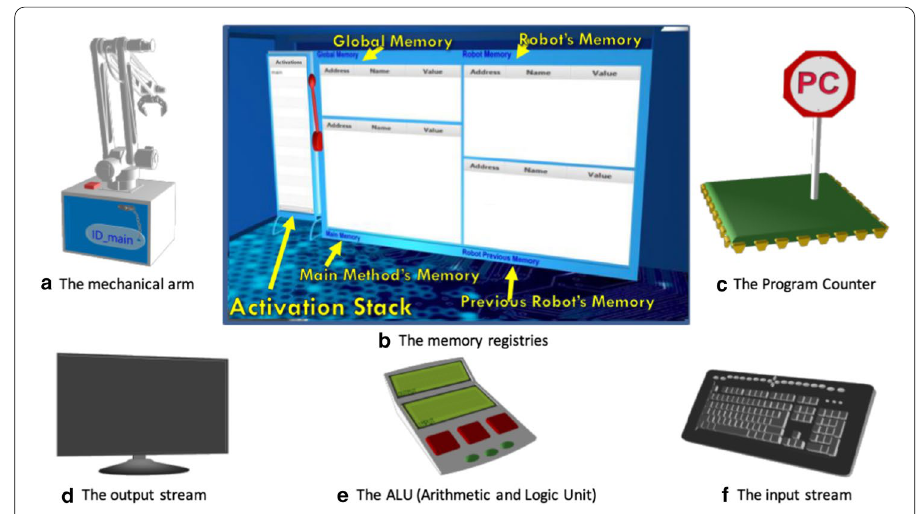
Fig. 2 Procedural programming. The mechanical arm metaphor